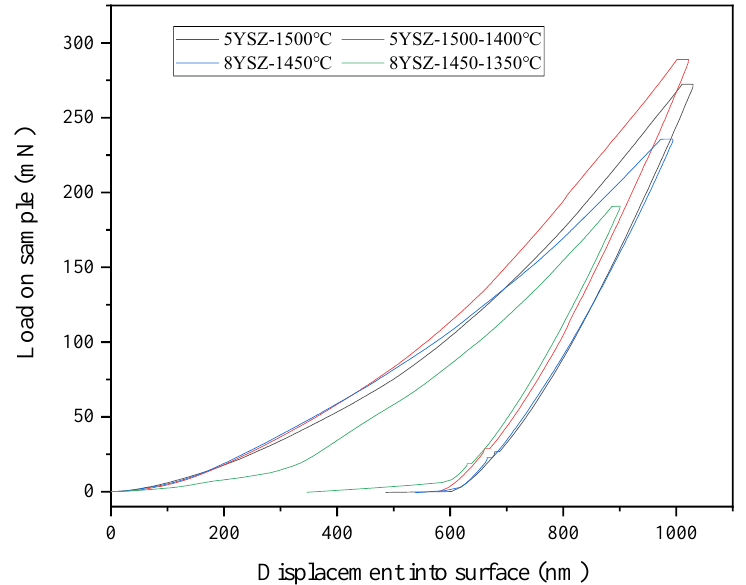
Figure 7. Displacement load diagram of four samples.